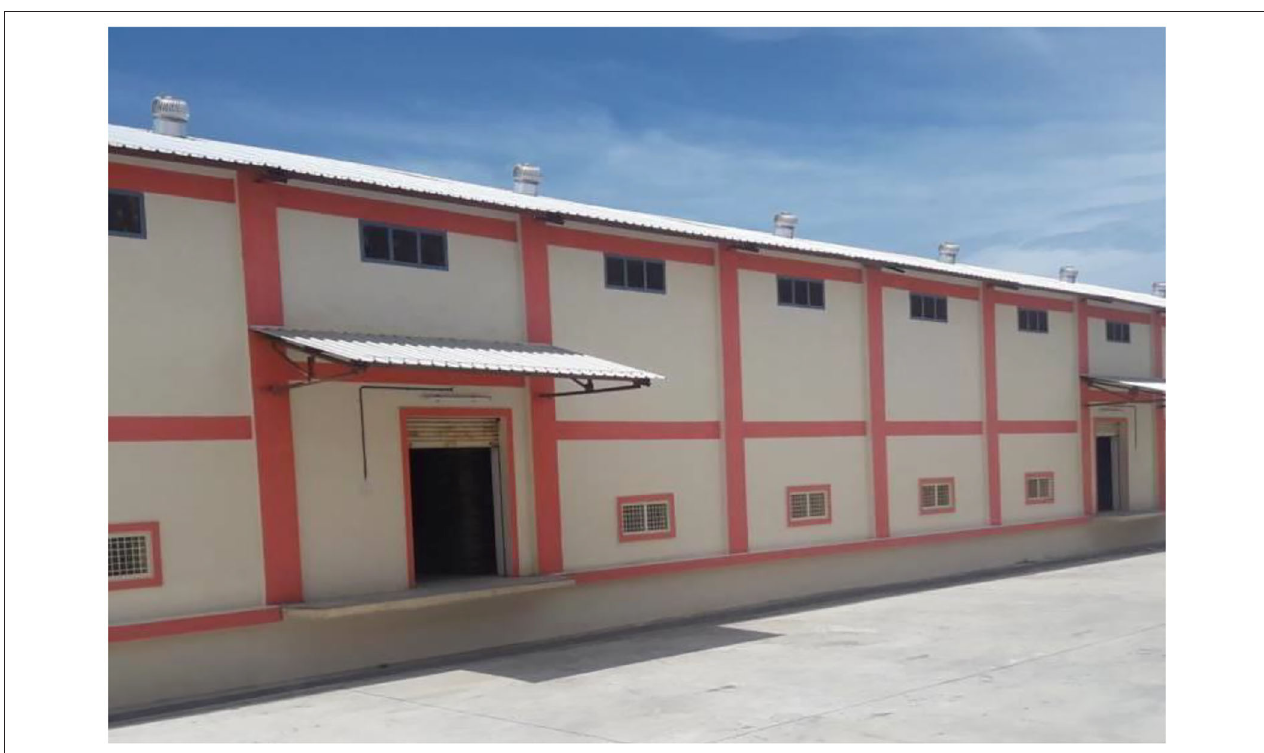
FIGURE 3 | Typical bag storage godown in